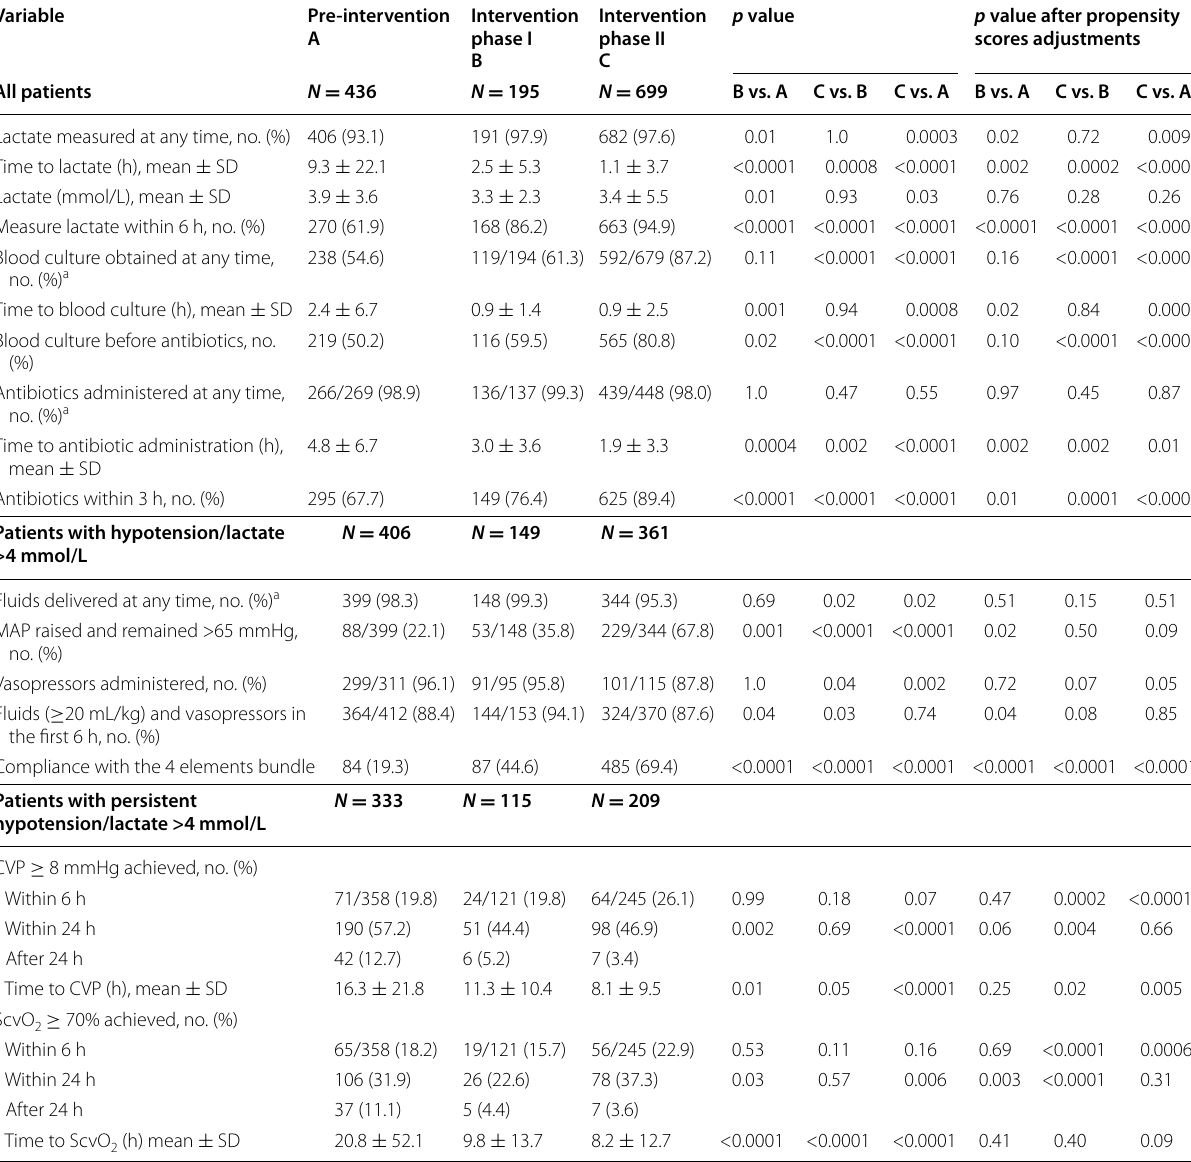
Table 2 Sepsis-related interventions during the treatment period for patients with sepsis or septic shock in the three study phases: pre-intervention (A), intervention phase I (B) and intervention phase II